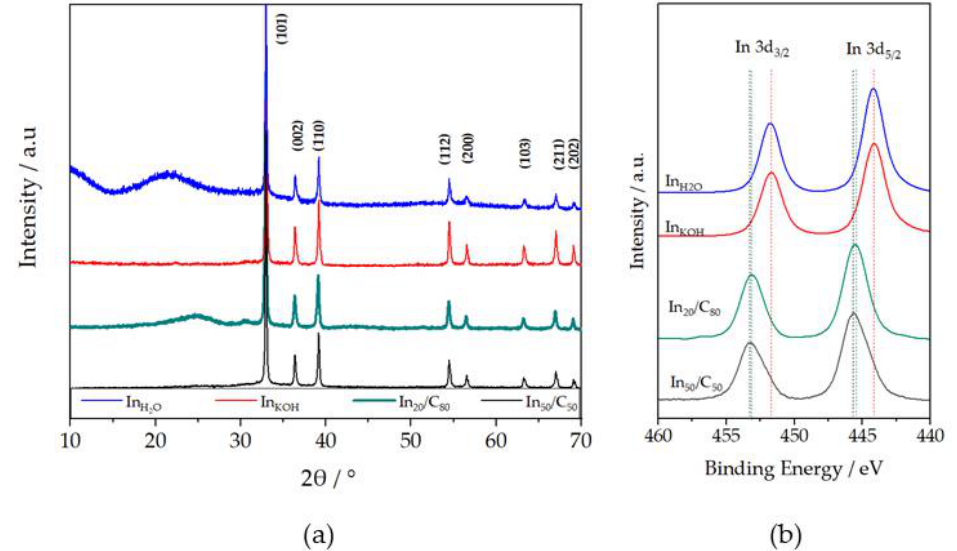
Figure 1. ( a ) X-ray diffraction patterns of In H2O , In KOH , In 20 /C 80 and In 50 /C 50 NPs, with lattice planes identification of mayor peaks [38,39]; ( b ) XPS spectra of In 3d for In KOH , In 20 /C 80 and In 50 /C 50 NPs.